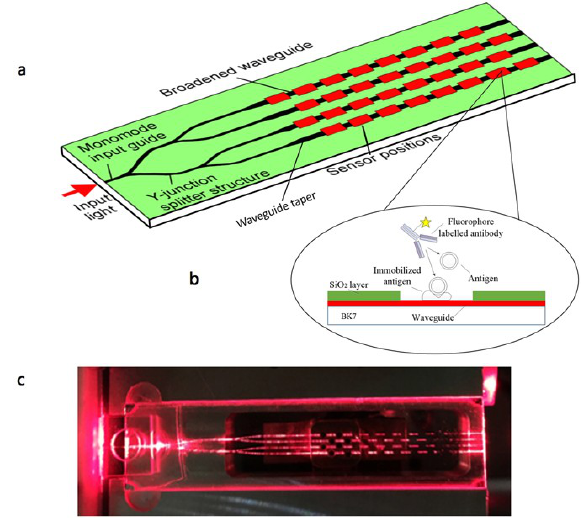
Figure 5. ( a ) Integrated optical sensor’s layout; ( b ) cross-sectional view, showing waveguide, isolation layer and location of the surface chemistry; ( c ) photo of light propagation along the waveguide chip (Photo credit: Lanhua Liu). Reproduced from [31] under a Creative Commons